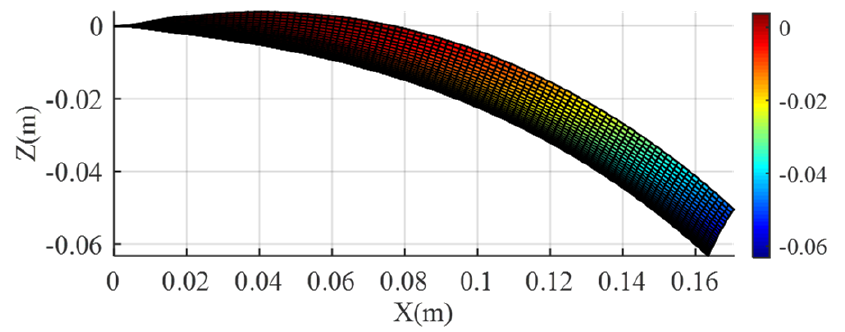
Figure 5. The deformation of a silicone cantilever based on the Yeoh model.